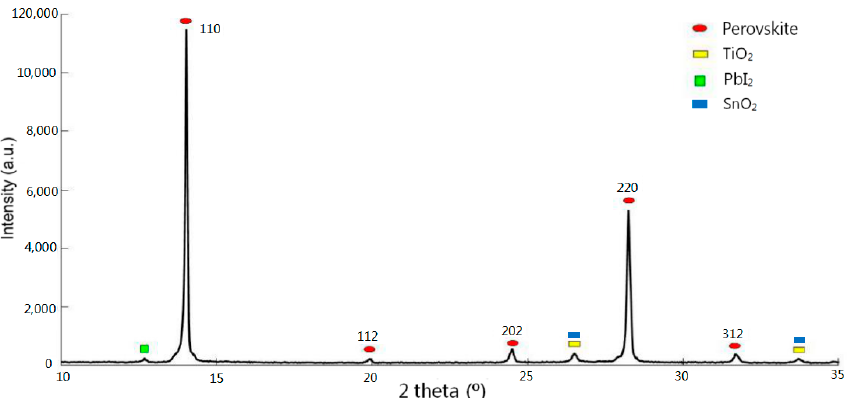
Figure 8. XRD pattern of the perovskite thin film deposited on FTO/TiO 2 /SnO 2 substrate in the case of spin ‐ coating SnO 2 at 3000 rpm.